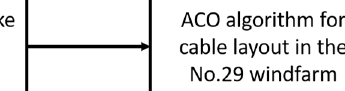
Table 2. Enercon 3 MW E-101 developed from [20].